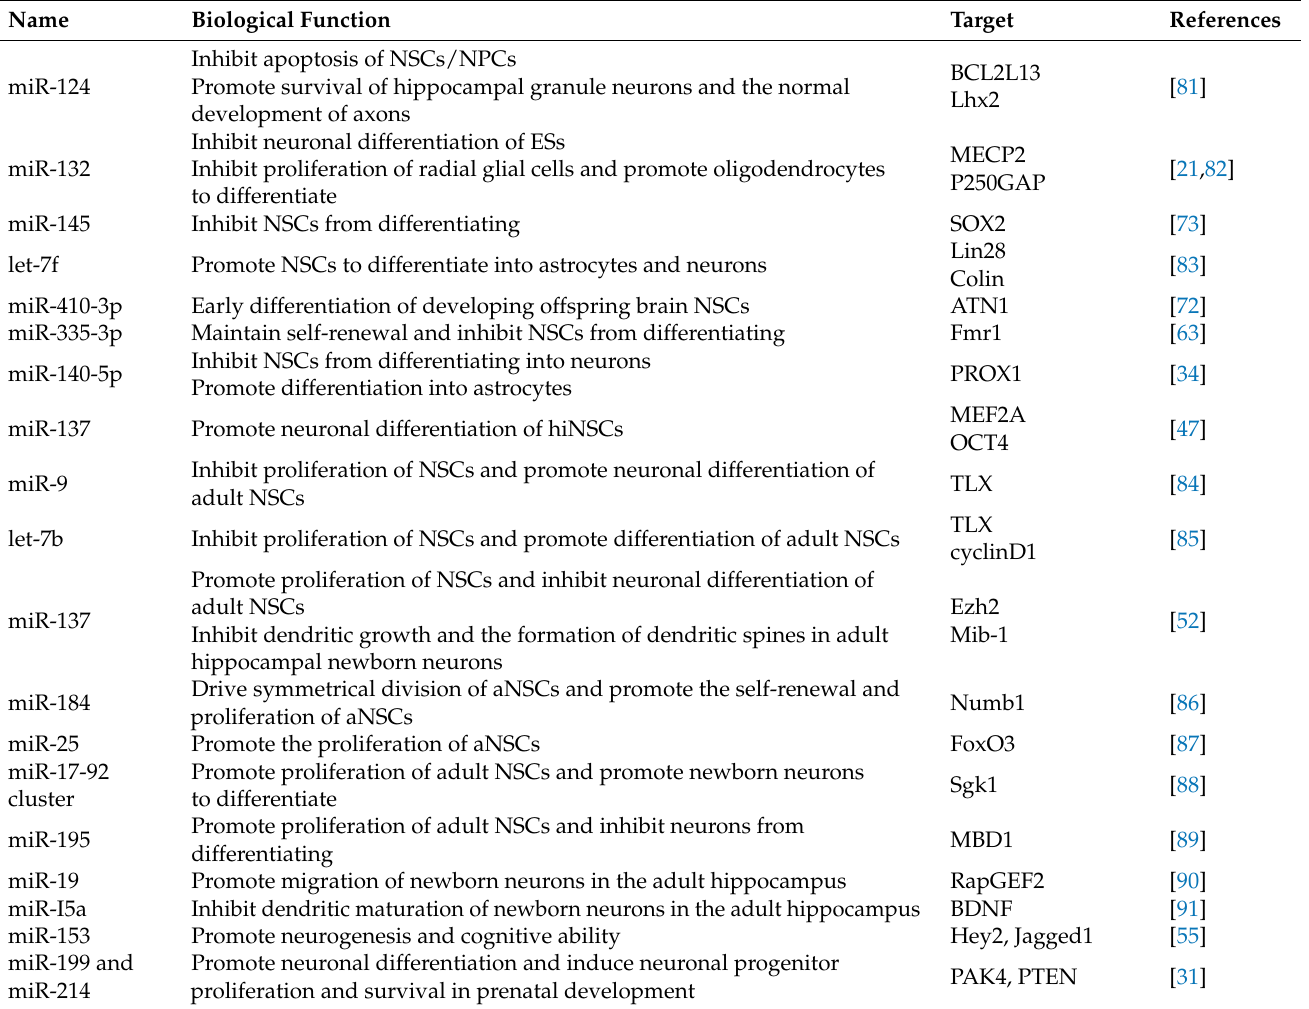
Table 1. Effects and mechanisms of various microRNAs in